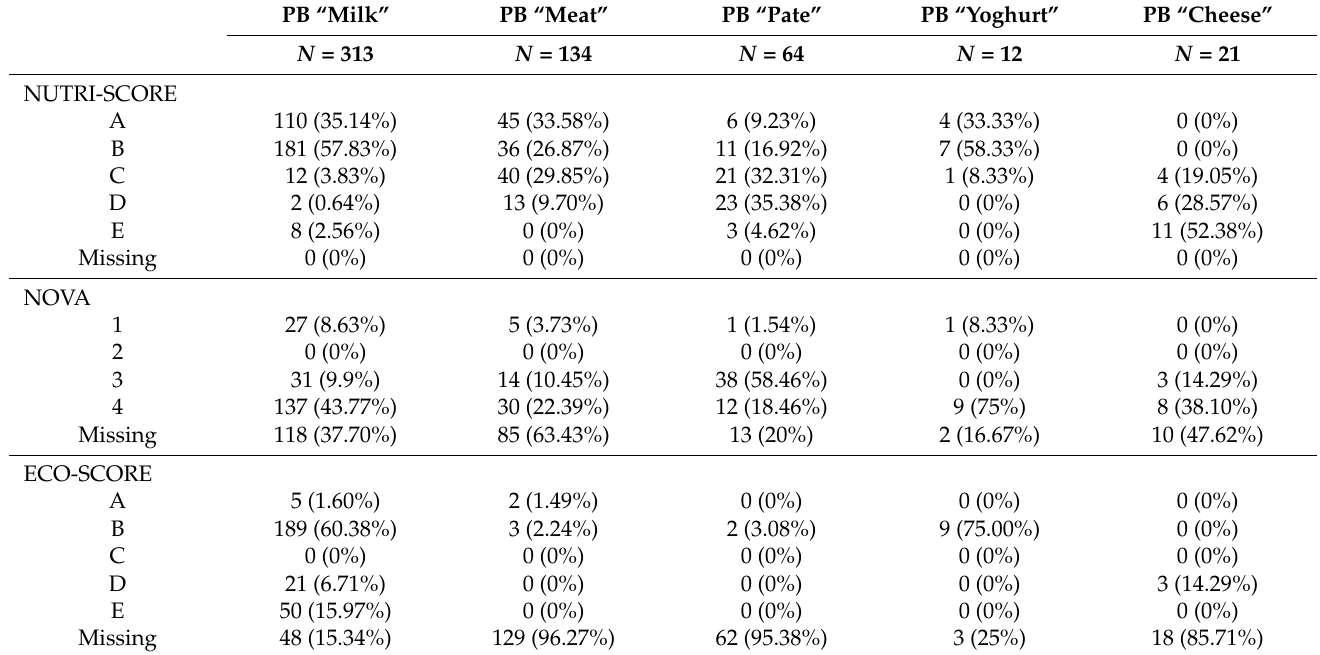
Table 3. Nutrient profiling models according to Nutri-Score, NOVA, and ECO-Score for PB “milk alternatives” and other PB